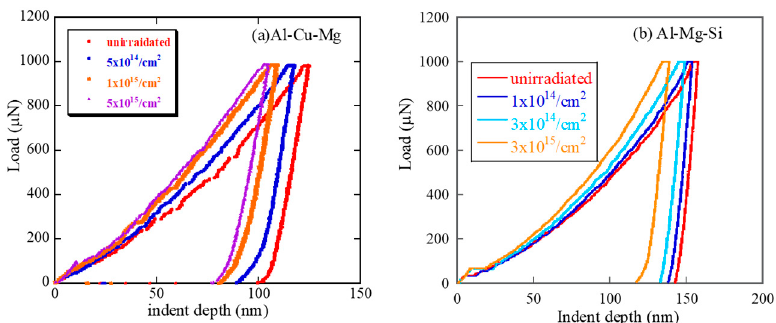
Figure 8. Results of nanoindentation for ( a ) Al-Cu-Mg alloy and ( b ) Al-Mg-Si alloy irradiated with 10 MeV I ions.